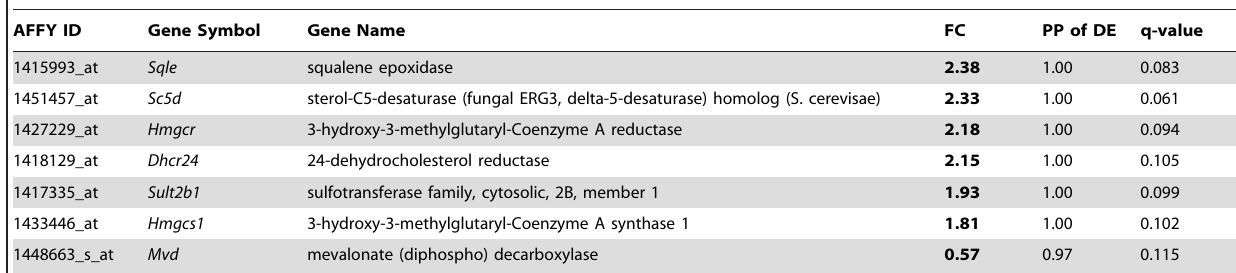
Table 10. Cholesterol